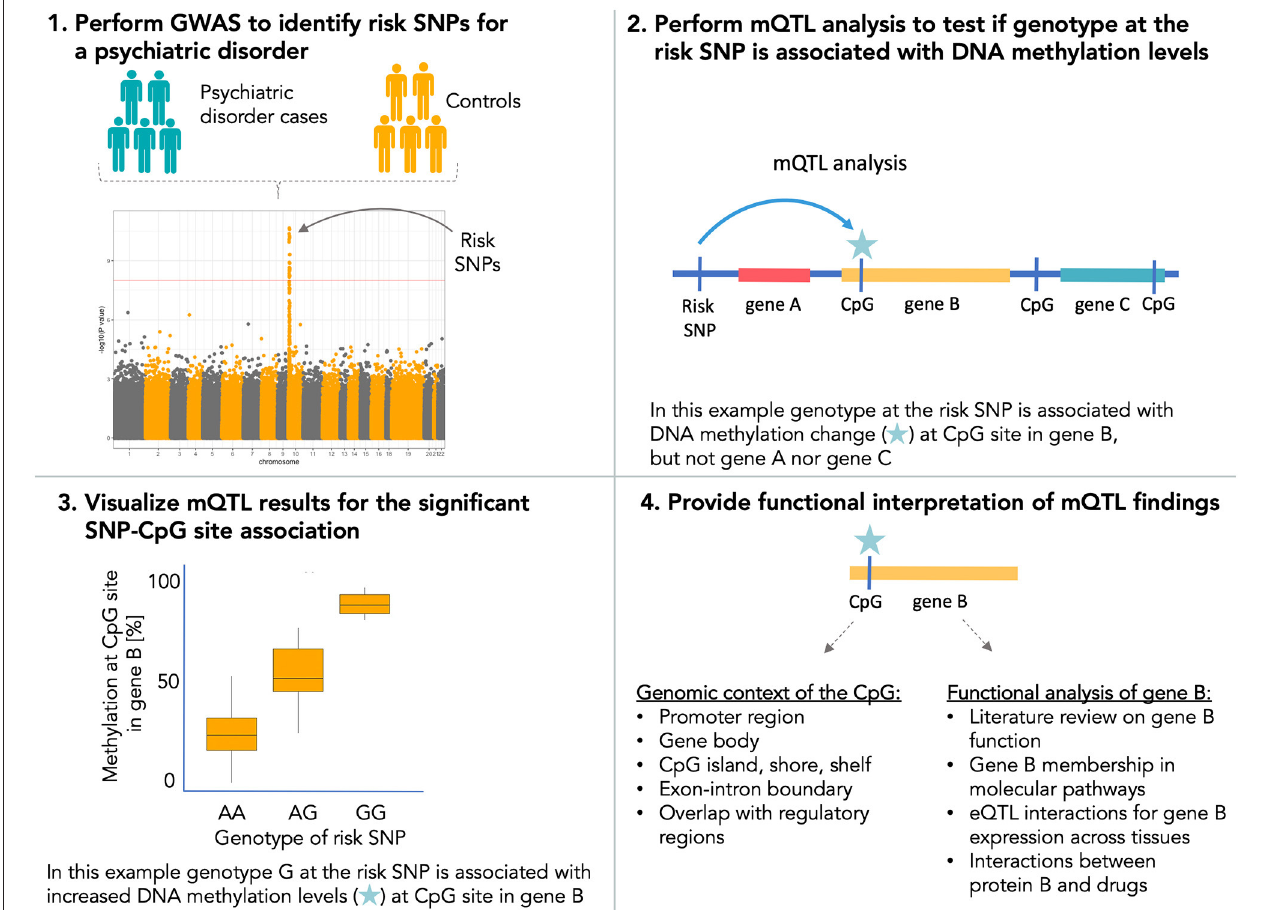
FIGURE 1 | Recommended workflow for using DNA methylation data for interpretation of the functional impact of risk single-nucleotide polymorphisms (SNPs) for psychiatric disorders.